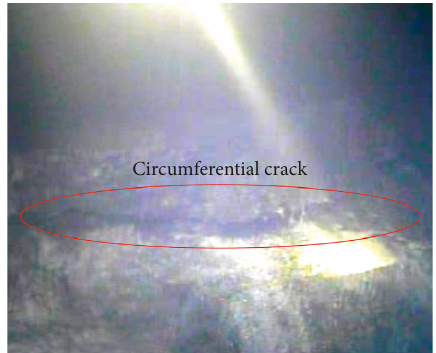
Figure 1: Shaft wall fracture in the Huang-Huai region.